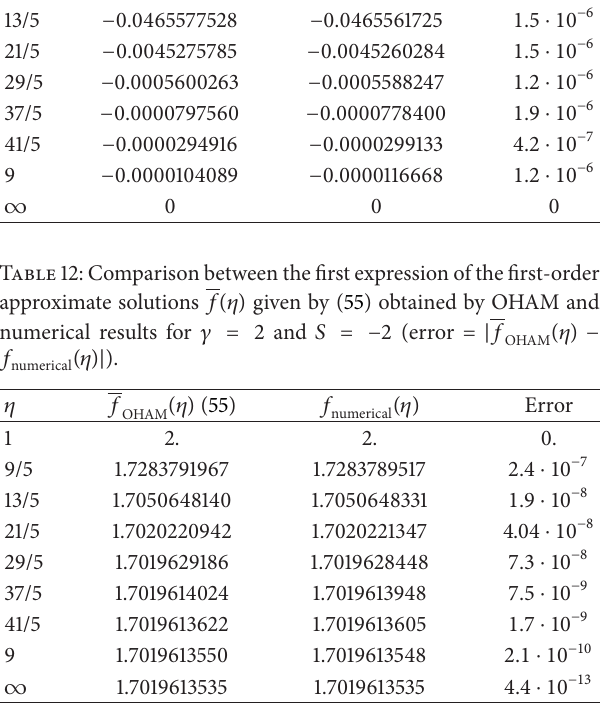
󸀠 (𝜂) obtained from 󸀠 (𝜂)− OHAM Figure 3: Displacement for different values of 𝑆 when 𝛾 = 2 .